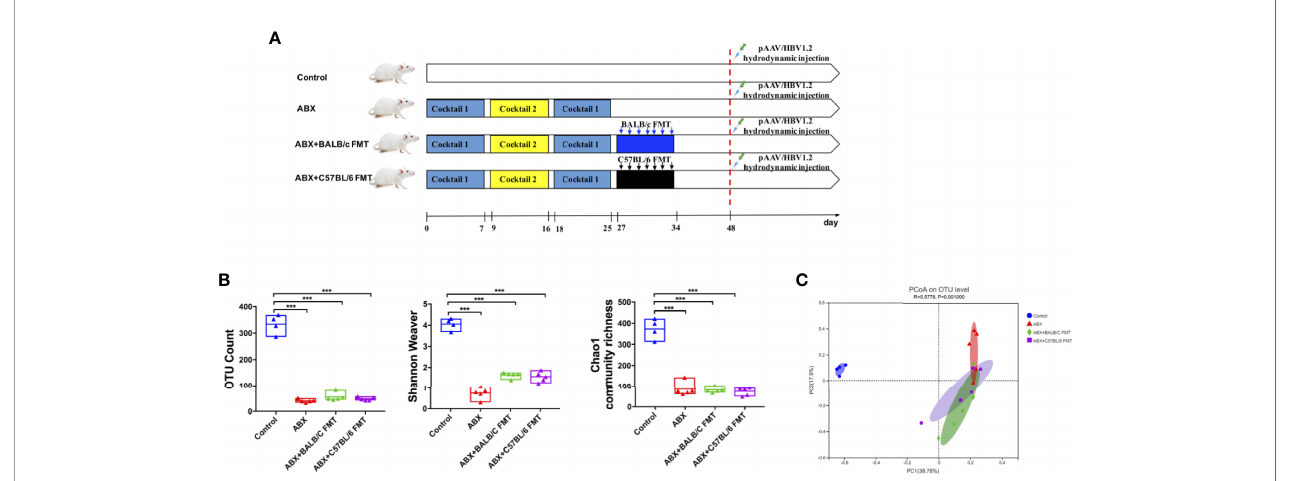
FIGURE 3 | Gut microbiota depletion by ABX treatment in BALB/c mice. (A) Schedule of the experiment. BALB/c mice were sequentially treated with two ABX cocktails. After treatment withdrawal, fecal microbiota from naïve BALB/c or C57BL/6 mice was transplanted into recipient mice by seven consecutive daily oral gavages. After reconstitution for 2 weeks, the mice were hydrodynamically injected with pAAV/HBV1.2. On day 25, the gut microbiota diversity was assessed based on OTU counts, Chao1 community richness, and the Shannon – Weaver index (B) and Bray-Curtis dissimilarity (C) . n = 4 in control group. n = 5 in ABX, ABX+BALB/